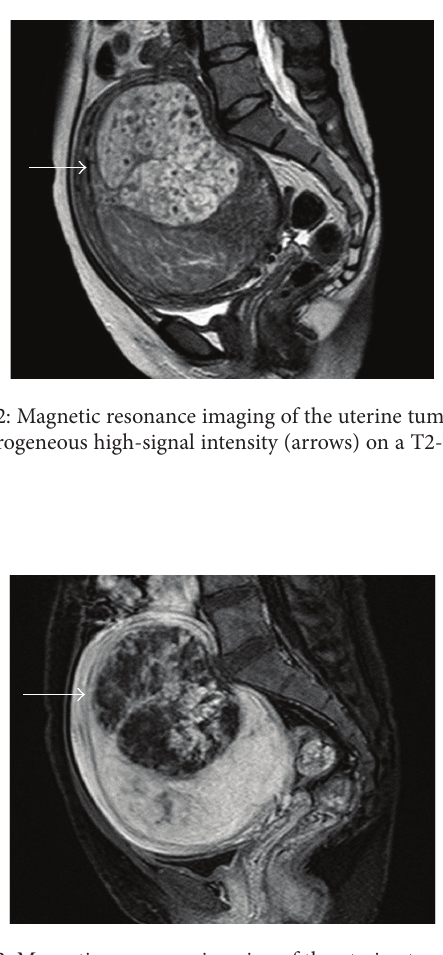
Figure 3: Magnetic resonance imaging of the uterine tumor show- ing heterogeneous contrast enhancement